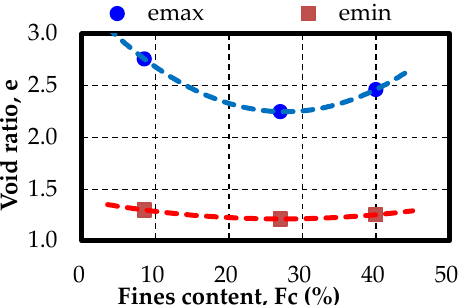
Figure 4. Influence of fines contents on compaction features of Komaoka volcanic soil ( A ) optimum water content w opt , ( B ) and maximum dry density ρ d max .